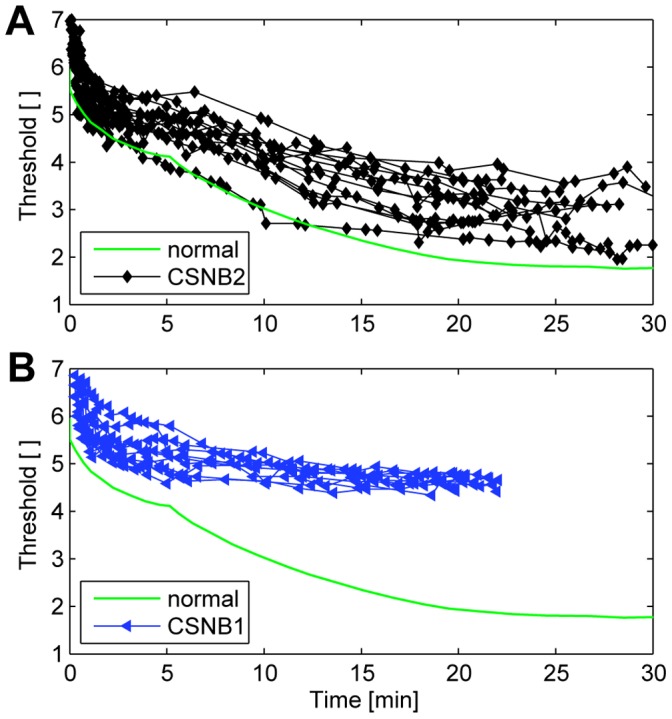
Dark adaptation curves of the CSNB2 patients (A) and CSNB1 patients (B), and a control subject (green curve).The normal DA curve shows a biphasic form, with an early cone-mediated phase and a later rod-mediated phase. The DA curves of the CSNB2 patients also showed such a biphasic form. Their final thresholds were variably elevated. The DA curves of the CSNB1 patients only showed a cone-mediated phase. Their final thresholds were all approximately 3 log units elevated.